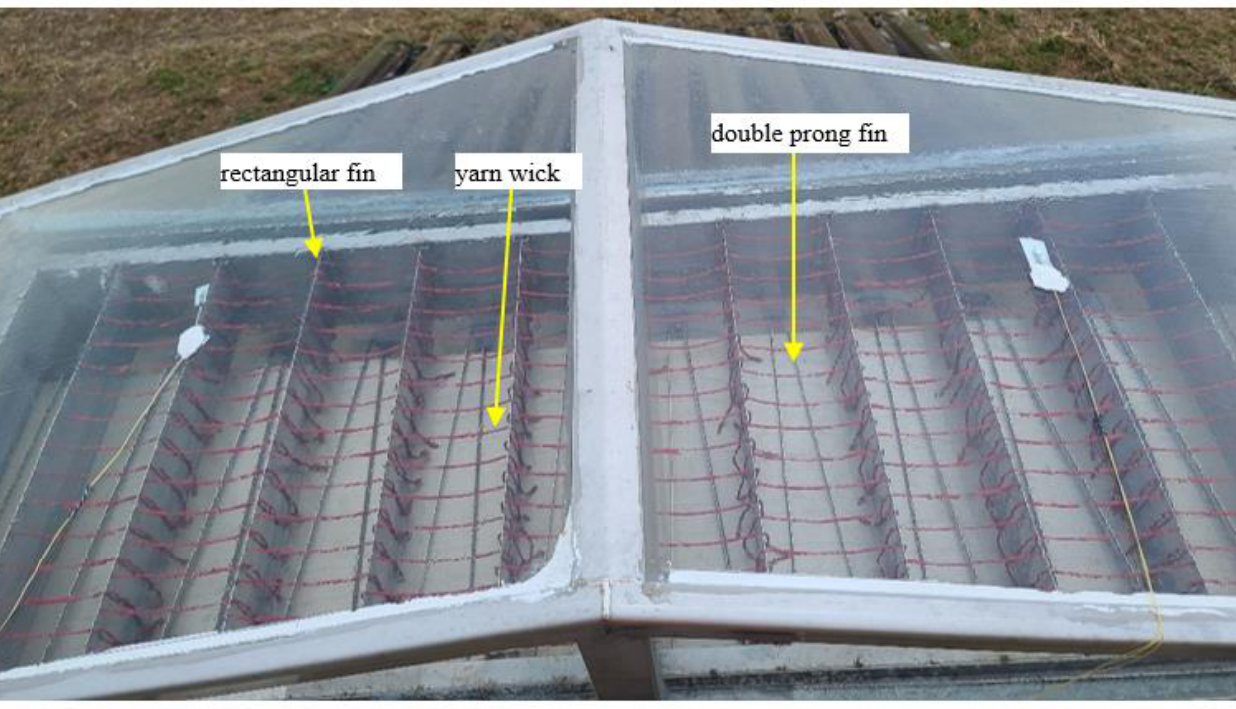
Figure 3. Aerial view of the fins and wicks installed in the basin.